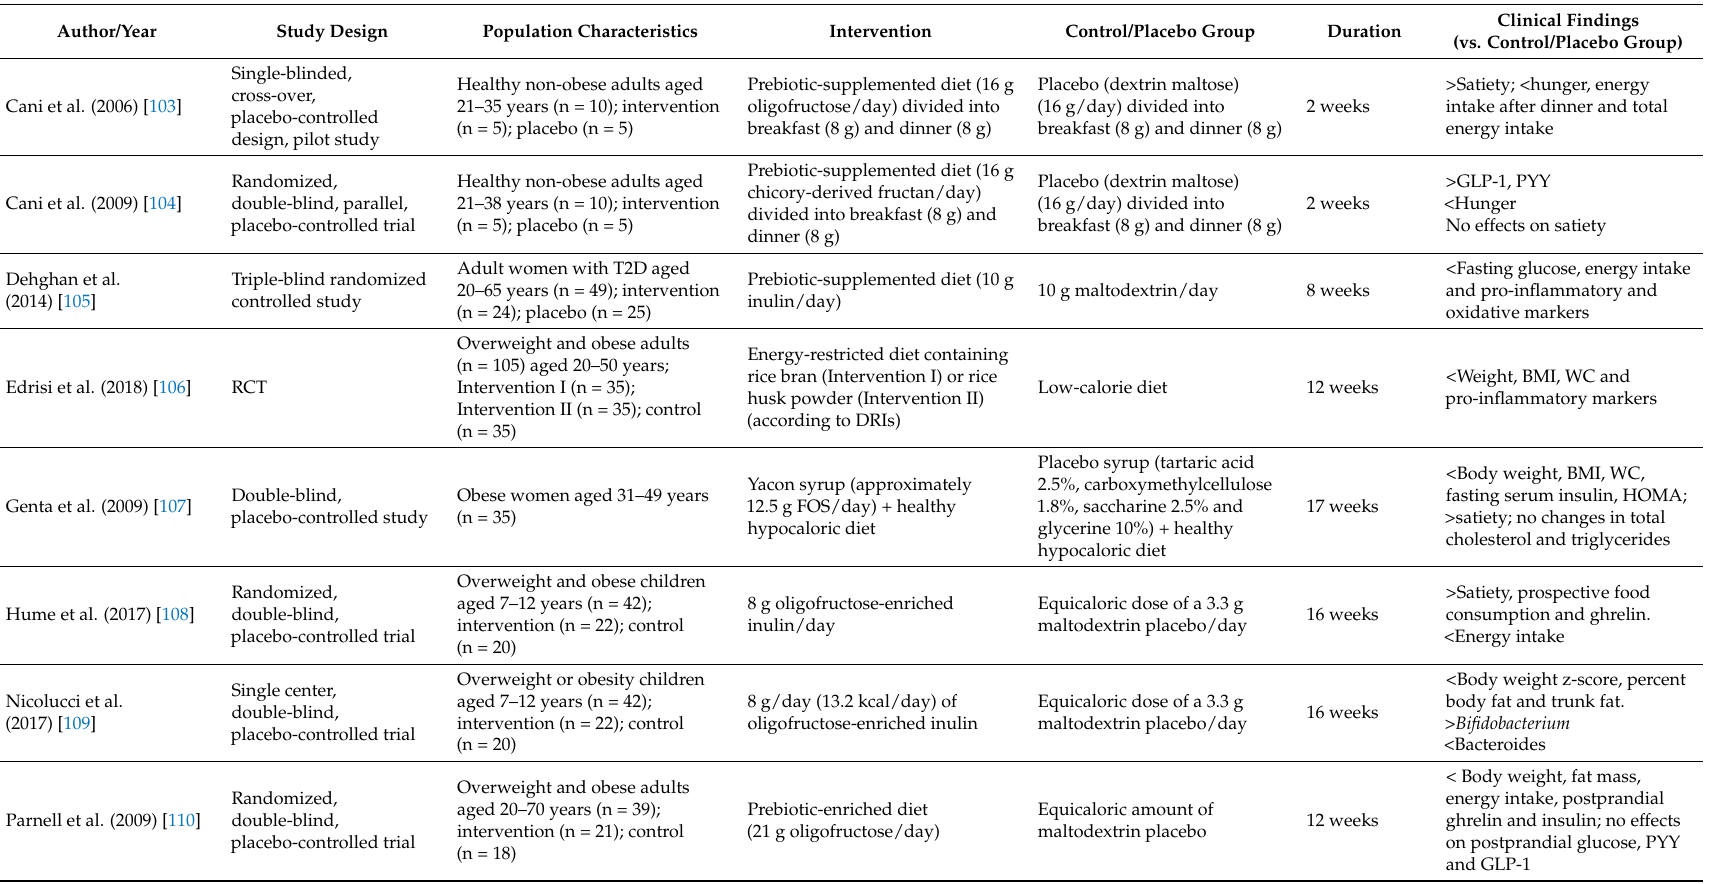
Table 2. Summary from clinical studies of impact prebiotic on obesity and associated